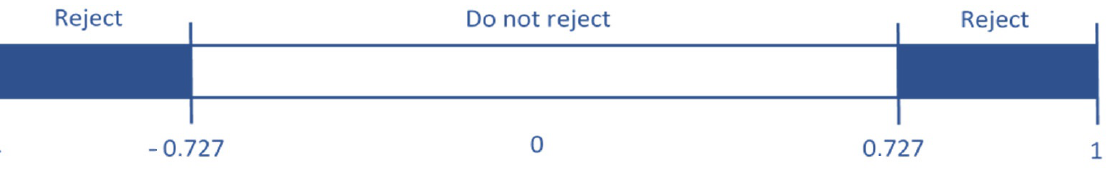
Figure 8. Degrees of freedom for hypotheses.